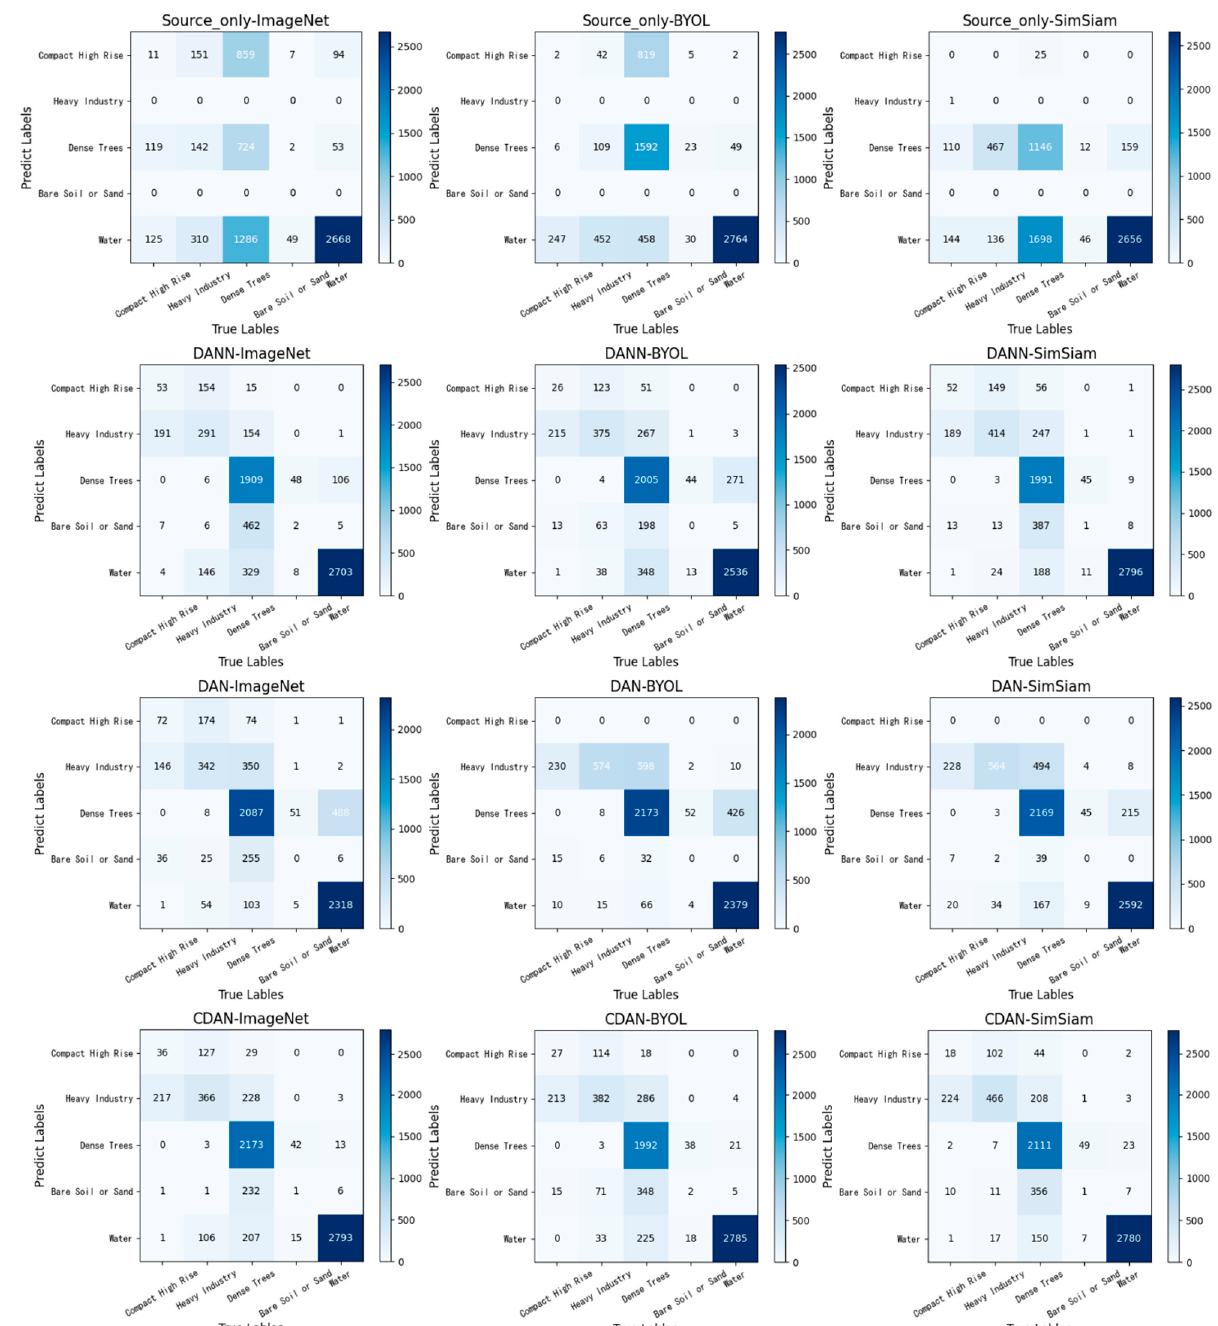
Figure 16. Confusion matrix obtained by different domain adaption methods based on different pretrained networks. The more labels for a class are predicted, the darker the color of the squares in the matrix. The numbers in the squares on the diagonal represent the correct numbers of predictions for each class label.